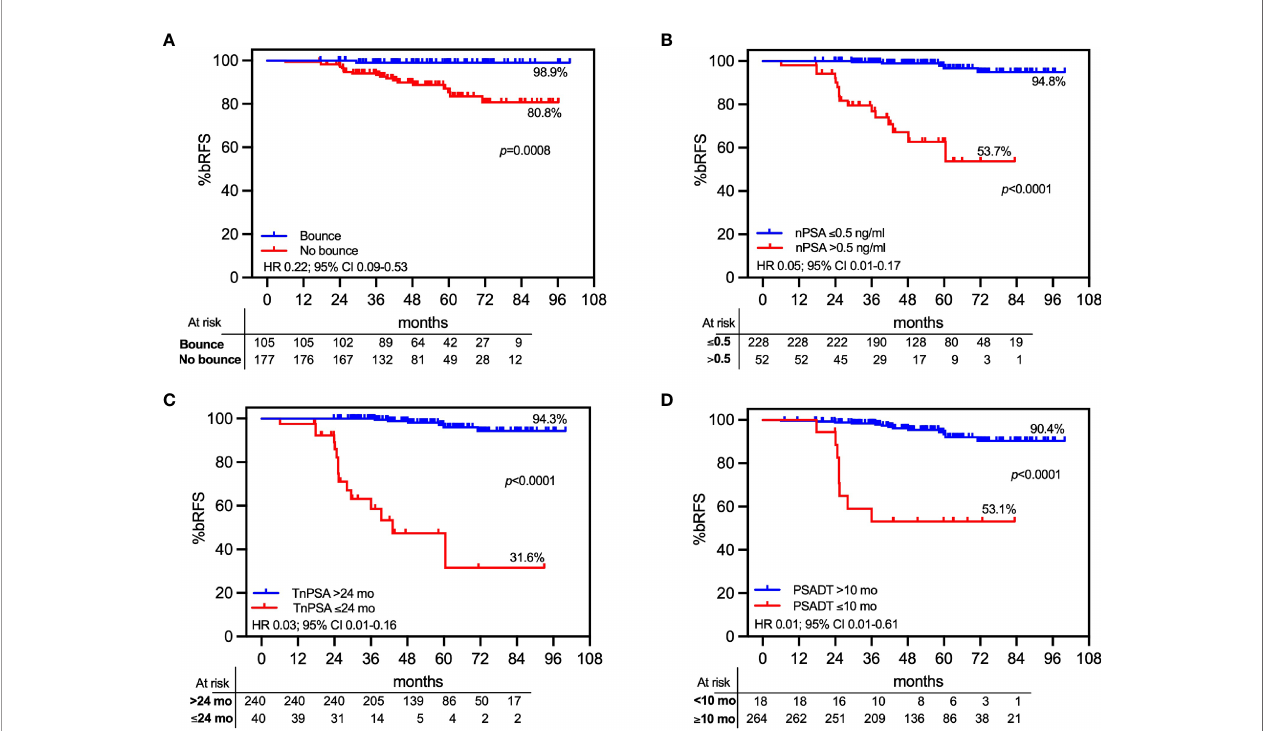
FIGURE 5 | Actuarial PSA relapse-free survival (bRFS) by landmarks of PSA relapse predictors. Only patients who did not receive androgen deprivation therapy (ADT) were included in the analyses. Patients classi fi ed by (A) benign PSA bounce; (B) nadir PSA cutoff at 0.5 mg/ml; (C) time to nadir PSA (TnPSA) with a cutoff time point at 24 months; (D) PSA doubling time with 10 months as cutoff